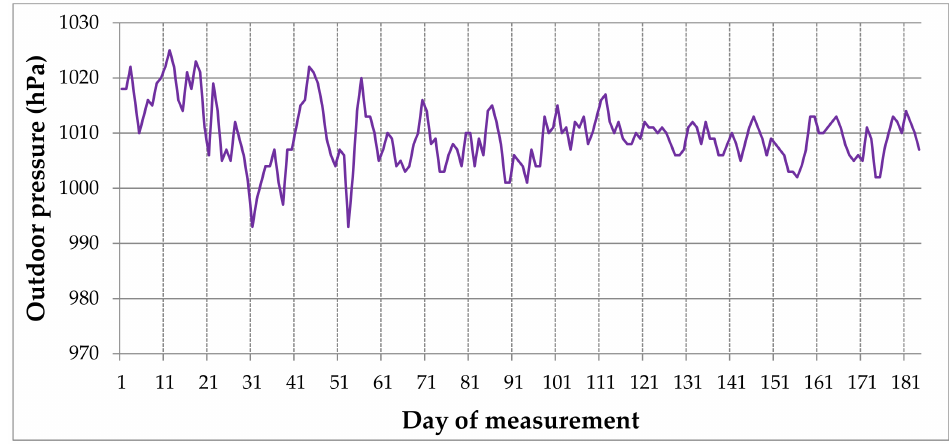
Figure 5. Daily variations of outdoor pressure during the measurement period.